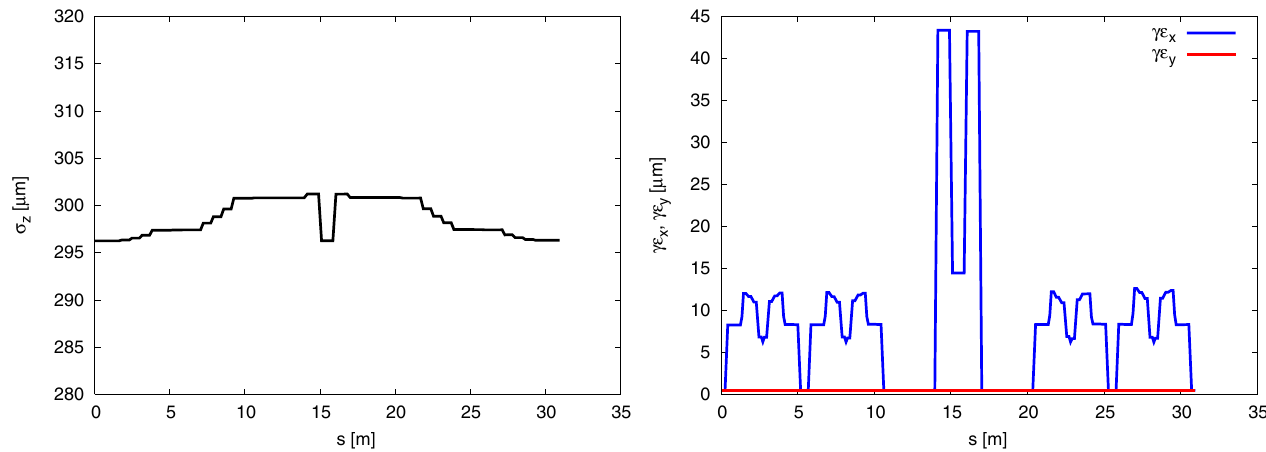
FIG. 8. The rms bunch length and projected normalized emittance evolution along the bypass beam line. Left: The rms bunch length. Right: Projected normalized emittance.